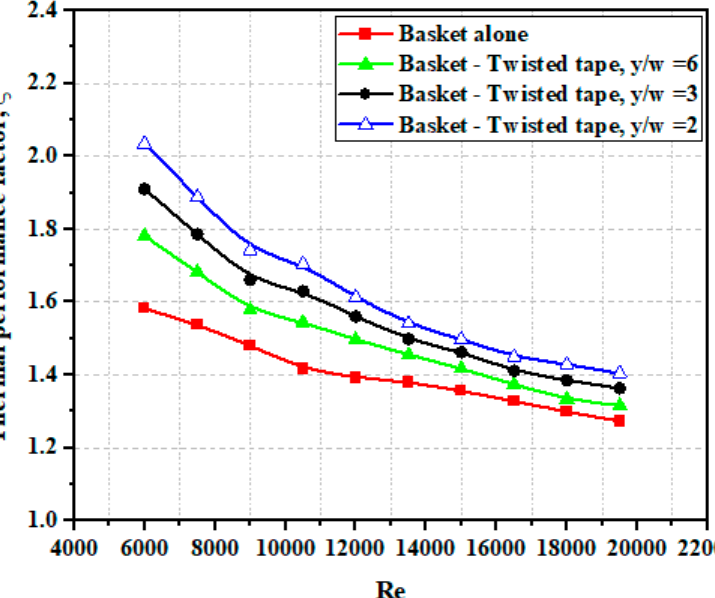
Figure 8. Variation of thermal performance factor with Reynolds number for heat exchanger fitted with basket alone and combined basket–twisted tape inserts.